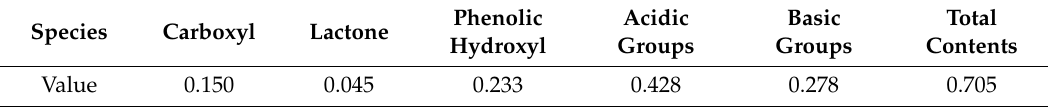
Table 1. Surface chemical characteristics of activated carbon (Unit: mmol /